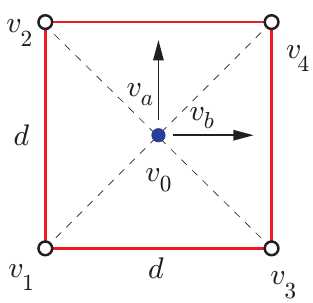
Figure 3. Redundant antenna configuration with four receivers.